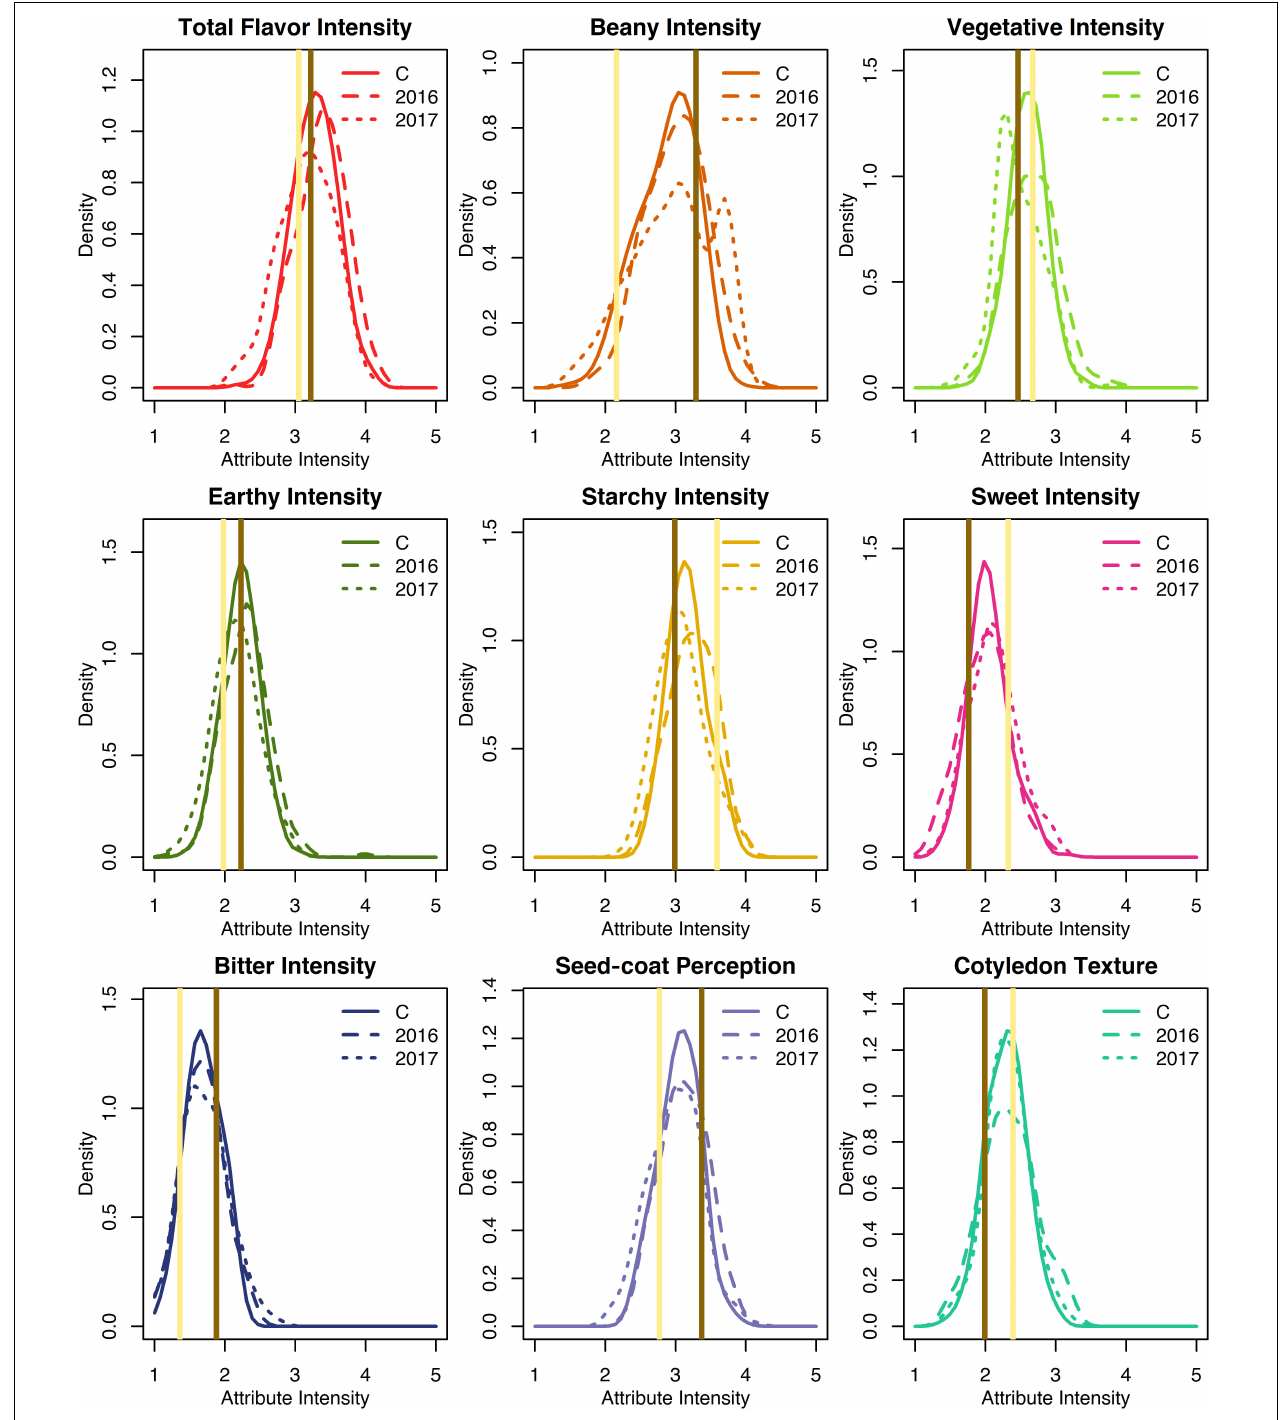
FIGURE 3 | Density plots of least squares estimates of sensory attribute intensities for the RILs from 2016, 2017, and both years combined (C). Attribute intensities for Ervilha and PI527538 from both years combined are indicated in yellow and brown, respectively.